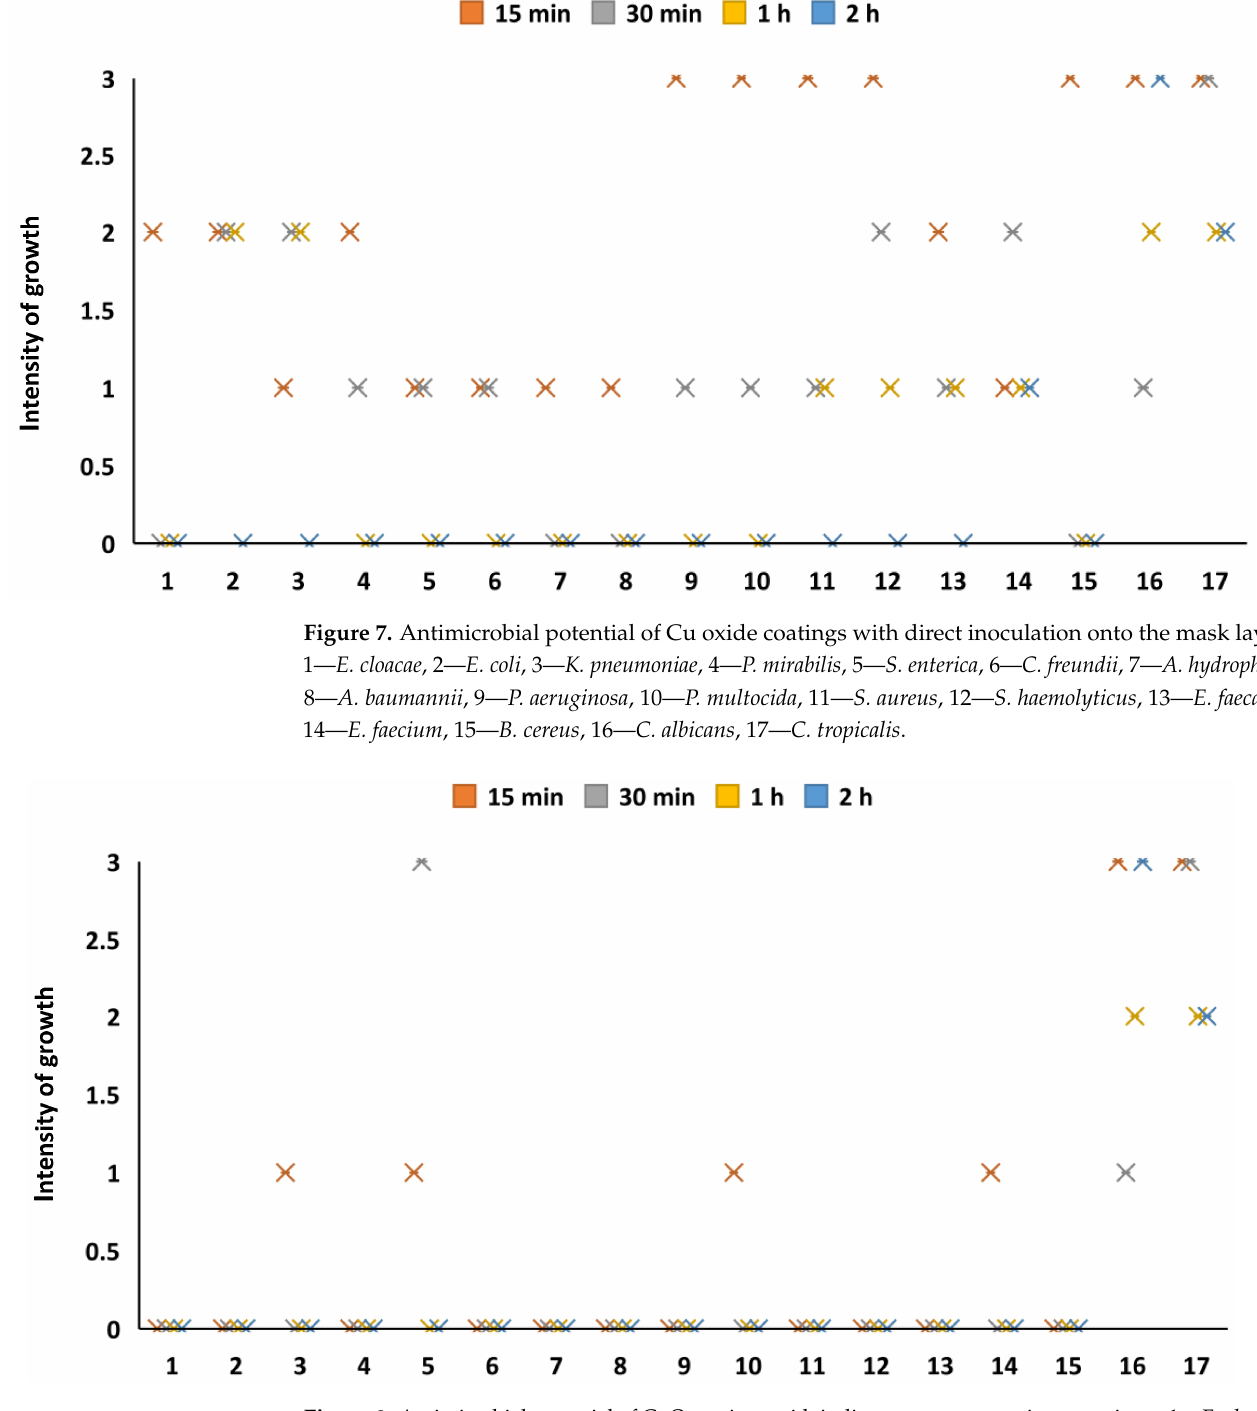
Figure 8. Antimicrobial potential of CuO coatings with indirect exposure to microorganisms. 1— E. cloacae